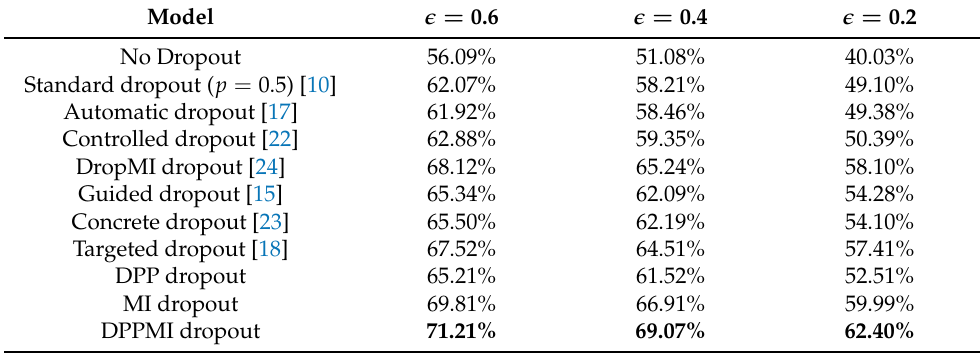
Table 3. The results of test accuracies regarding different training set sizes on CIFAR10 benchmark. The parameter (cid:101) determines the portion of training sample number per class from original dataset. The best test results are marked in bold